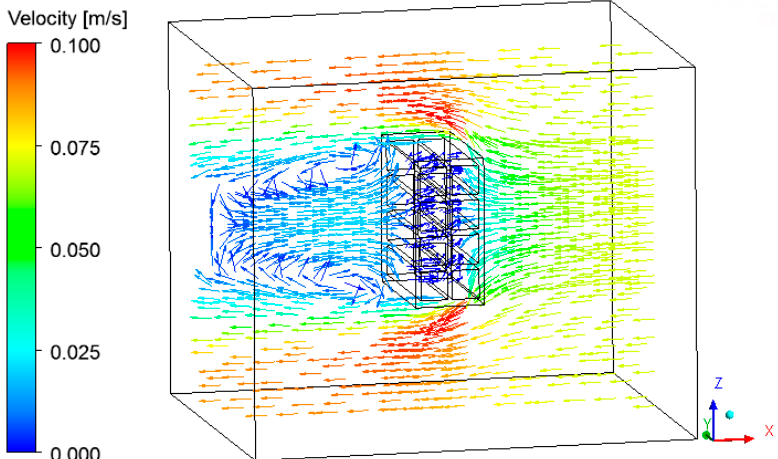
Figure 17. Vector field of the air in the plane XZ (Z = 0.197 m) at the instant 950 min.